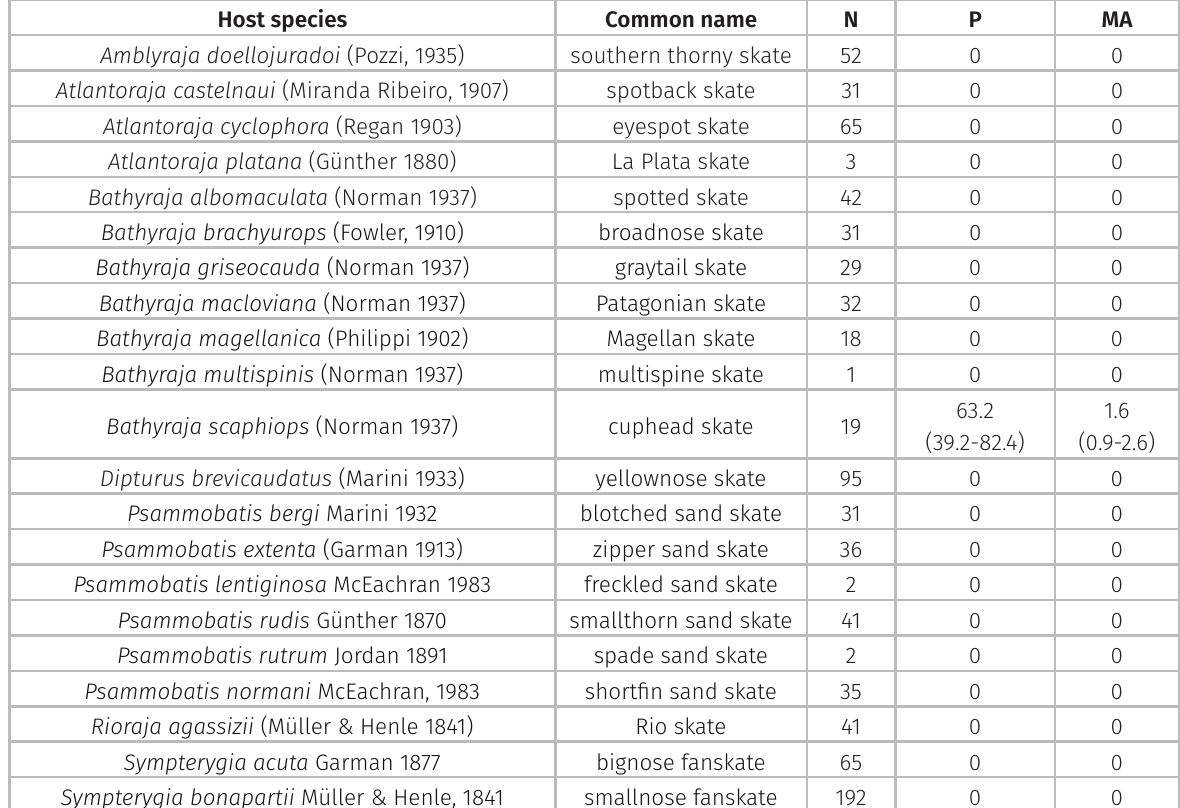
Table I. Composition of samples of 21 skate species in the Argentine Sea and population descriptors of Dendrapta nasicola n.